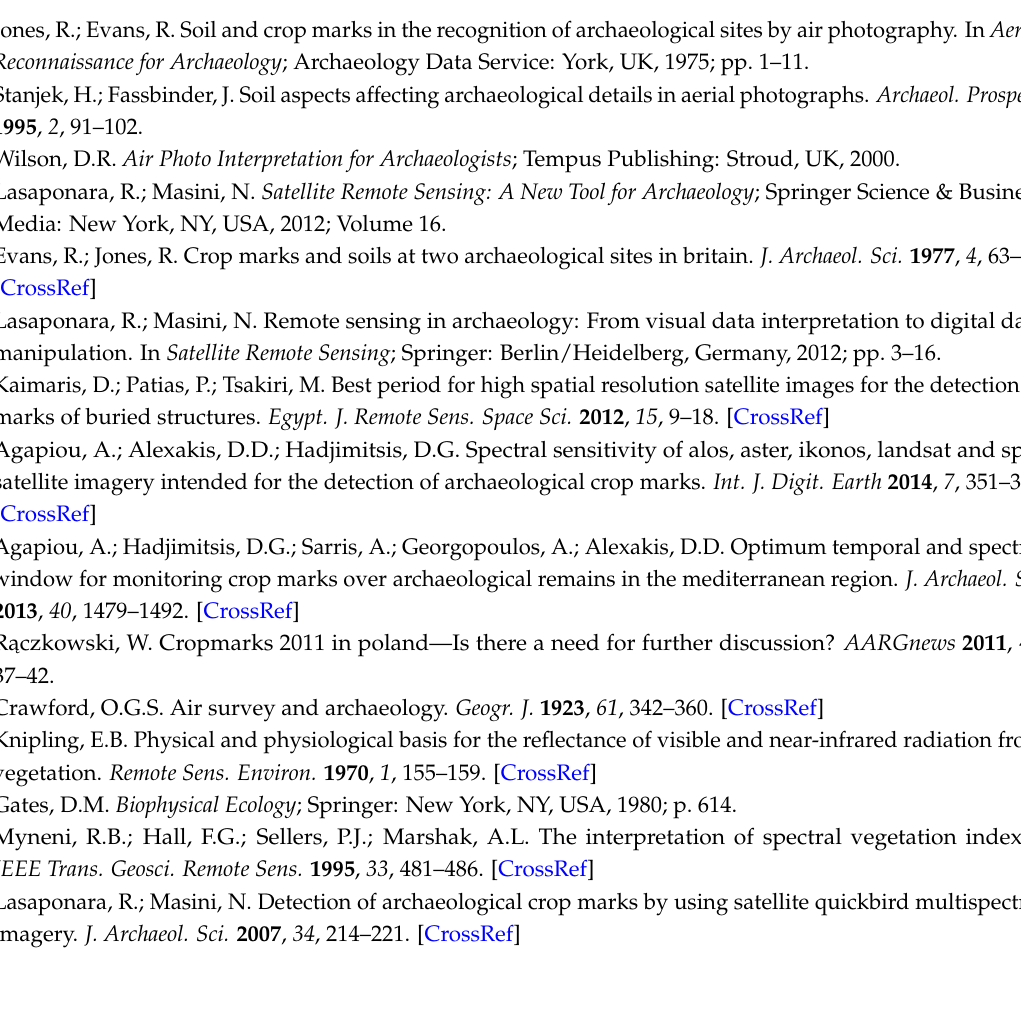
Table S1: Full list of COSMO SkyMed data used for the